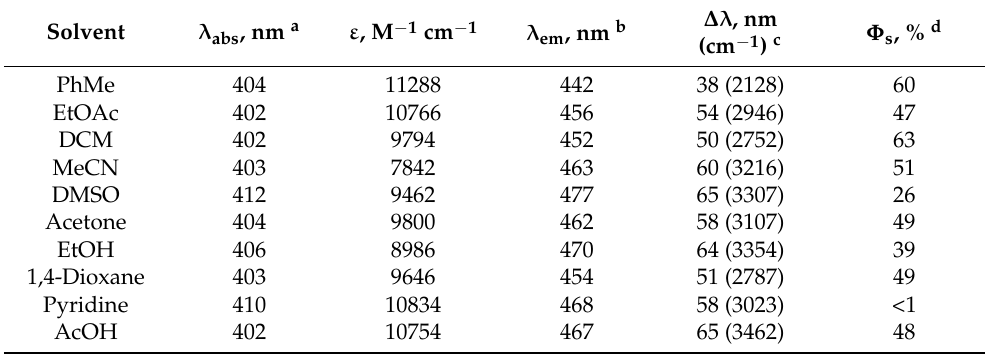
Table 2. Solvatochromic properties of the compound 2d.